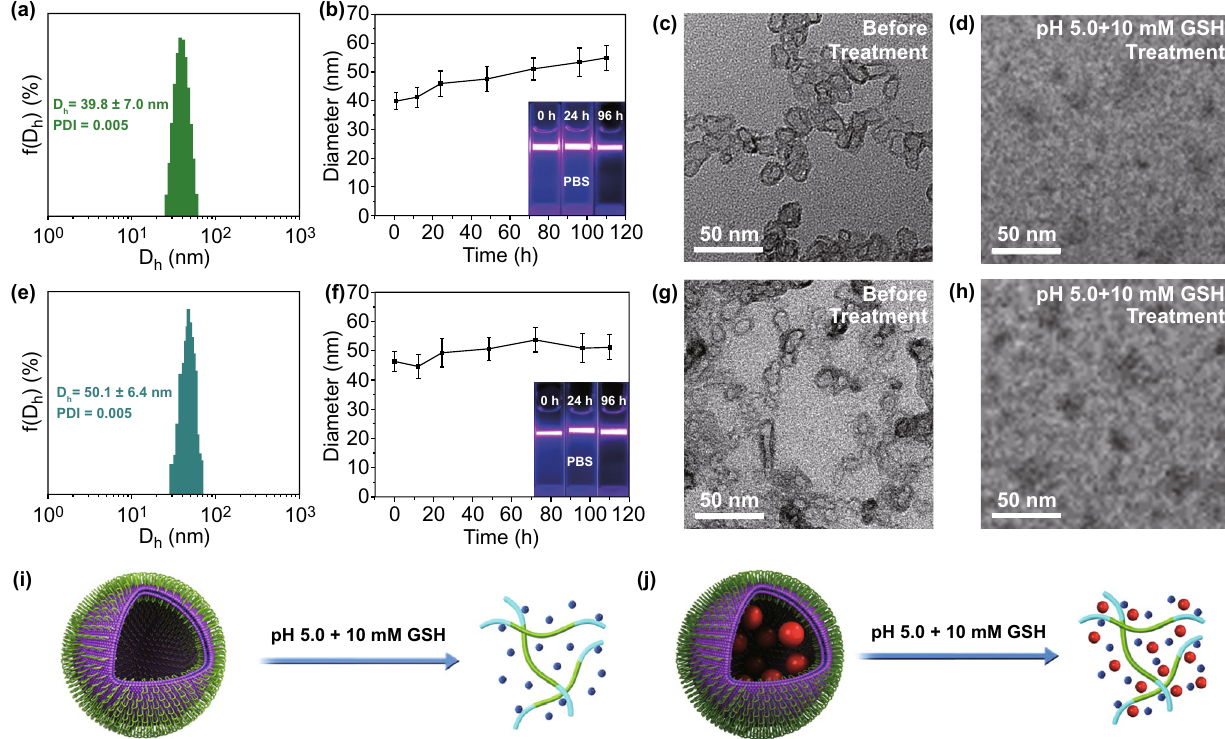
Fig. 3 a D h distributions, b hydrodynamic particle size and Tyndall effect of dispersed stability of PAA 68 – b –PEG 86 – b –PAA 68 /MnO 2 in PBS at different times. TEM images c before and d after dissociation of PAA 68 – b –PEG 86 – b –PAA 68 /MnO 2 . e D h distributions, f hydrodynamic particle size and Tyndall effect of dispersed stability of DOX-loaded PAA 68 – b –PEG 86 – b –PAA 68 /MnO 2 in PBS at different times. TEM images g before